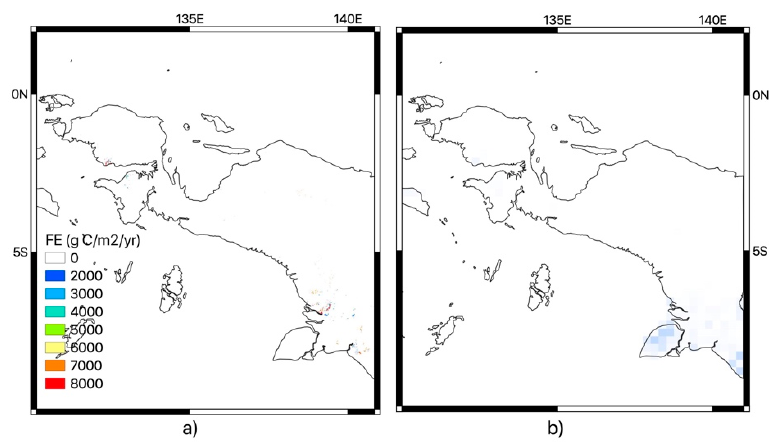
Figure A1. Spatial distribution of mean annual fire emissions from 2002 to 2018 of ( a ) this study and ( b ) GFED 4.1s in the Papua region in Eastern Indonesia. The same color scheme was used for both ( a , b ). More fire emissions were confirmed in ( a ) FE in this study compared with ( b ) GFED 4.1s.